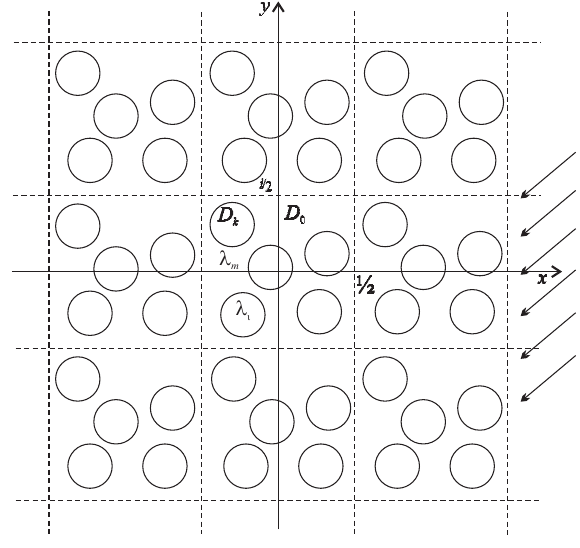
Figure 1. The representative cell Q (0 , 0) within doubly periodic